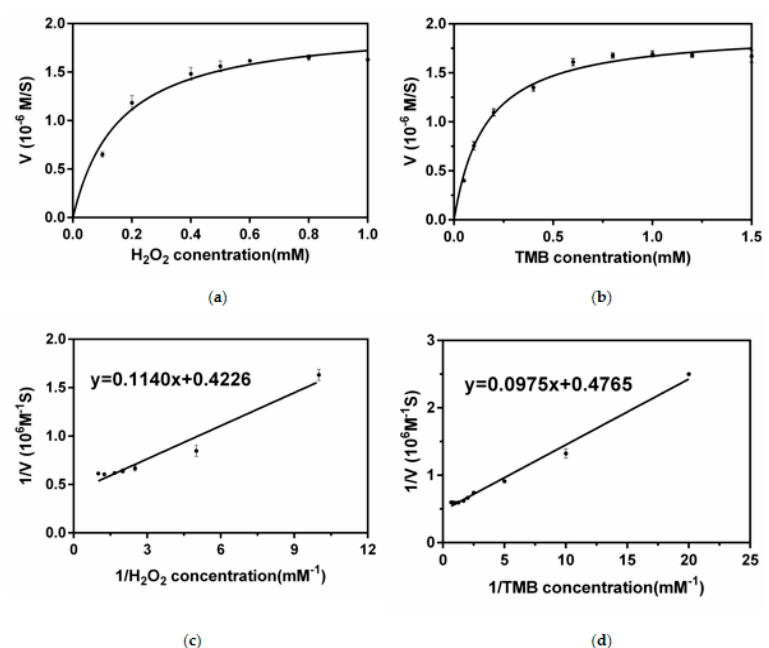
Figure 3. Kinetics assay of Dh–A–H–E. ( a ) Michaelis–Menten curves against H 2 O 2 concentration, in which the concentration of TMB was fixed at 2.0 mM; ( b ) Michaelis–Menten curves against TMB concentration, in which the concentration of H 2 O 2 was fixed at 1.0 mM; ( c ) double–reciprocal curves against H 2 O 2 , in which the concentration of TMB was fixed at 2.0 mM; and ( d ) double–reciprocal curves against TMB, in which the concentration of H 2 O 2 was fixed at 1.0 mM. Experiments were performed in triplicate to obtain the mean value. Table 1. The catalytic efficiency of Dh–A–H–E.